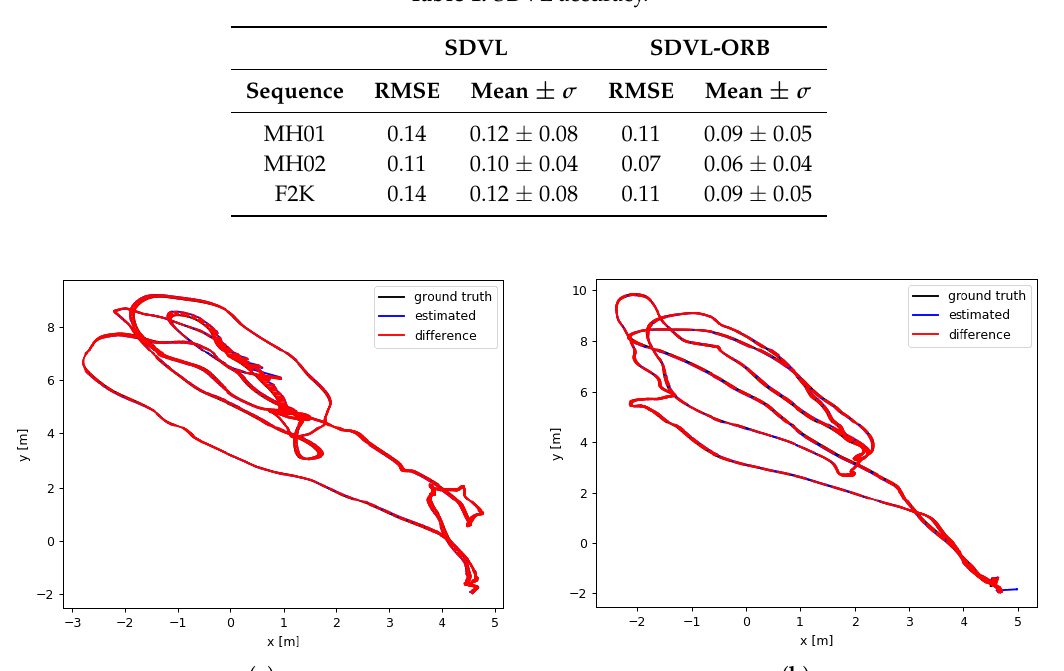
Figure 5. Difference between estimated pose and ground truth in MH01 ( a ) and MH02 ( b ) sequences using ORB descriptors for